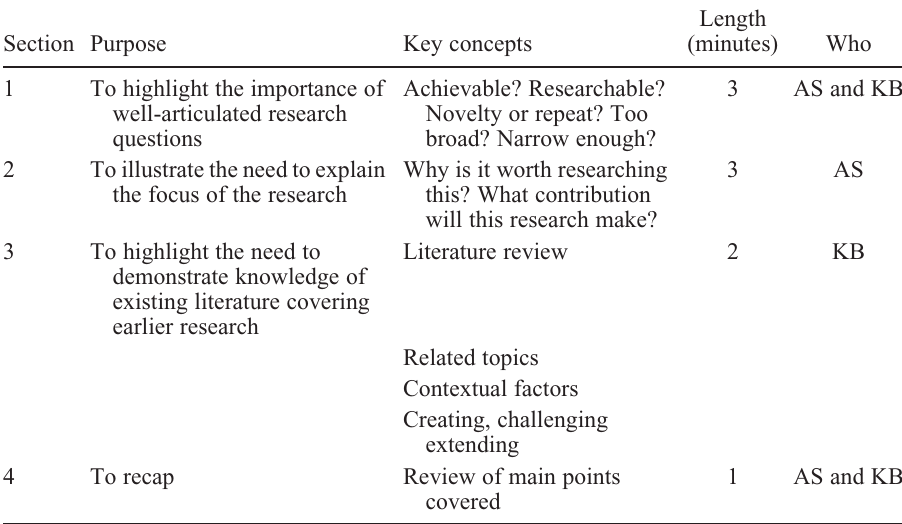
Table 2. Planning tool applied to a Research Methods podcast. Section